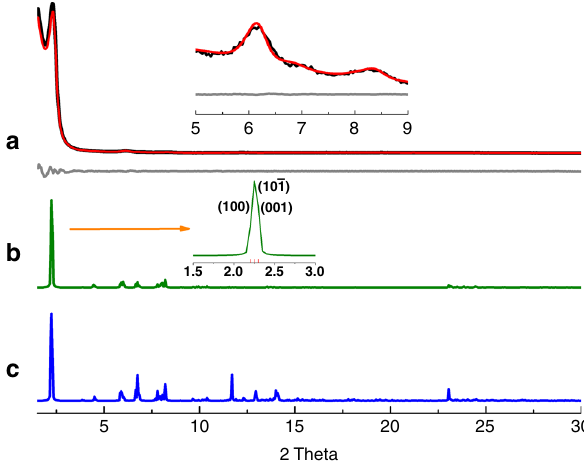
Fig. 4 PXRD pro fi les of Tri-COF-BZ . a Experimental (black) and Pawley re fi ned (red) PXRD patterns and difference plot (gray) between them, b simulated PXRD patterns with AA stacking, and c AB stacking